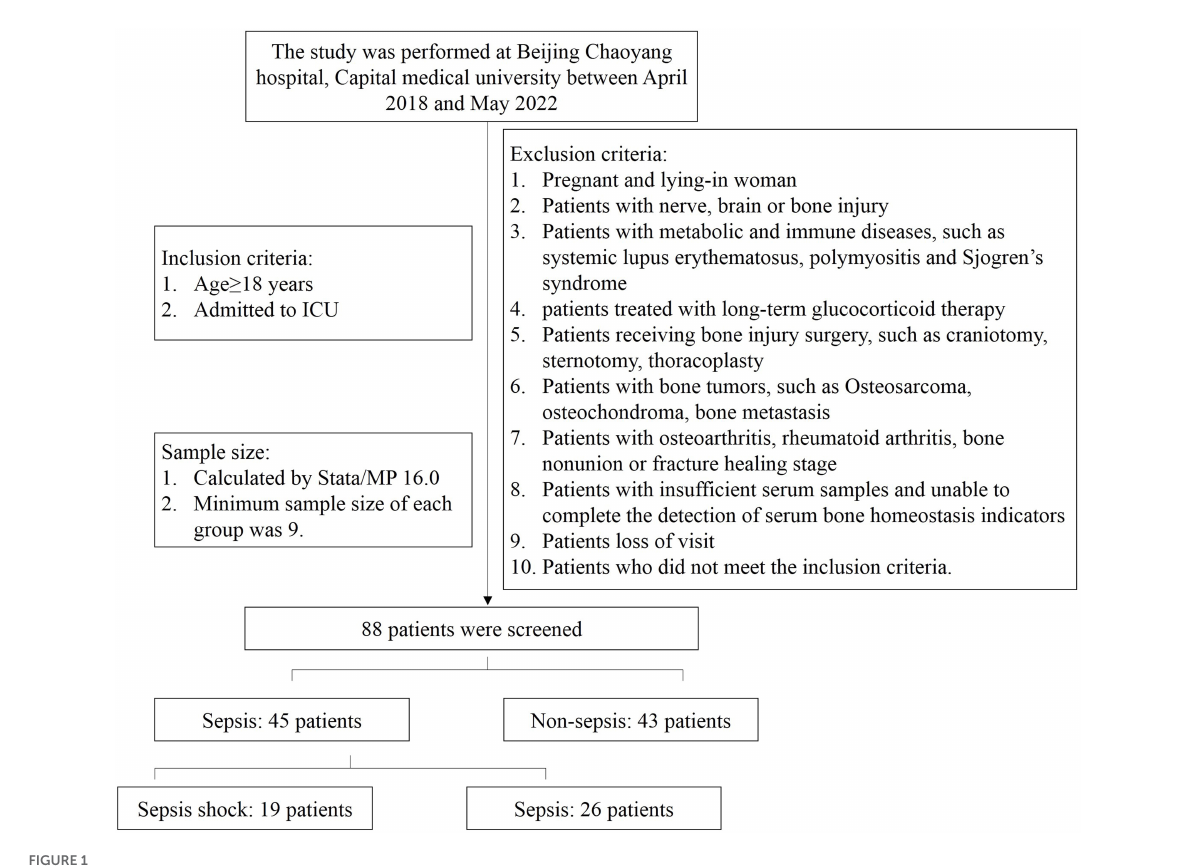
FIGURE1 Study flow